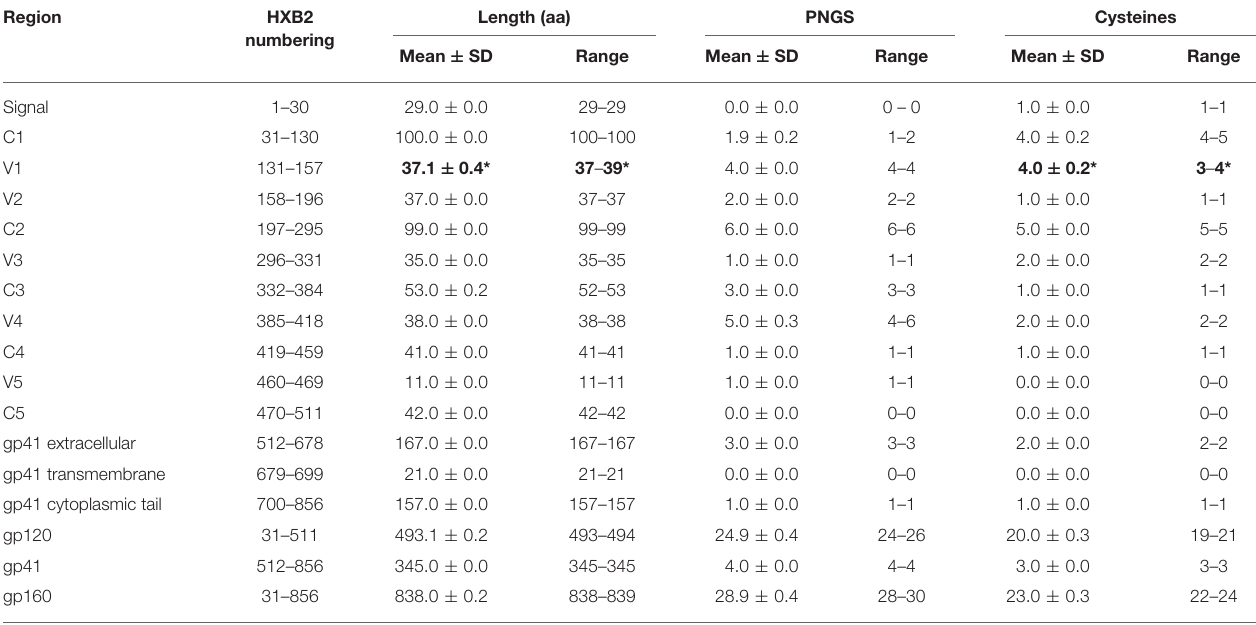
TABLE 2 | Physical characteristics of 20 functional proviral sequences isolated from EN3. Region